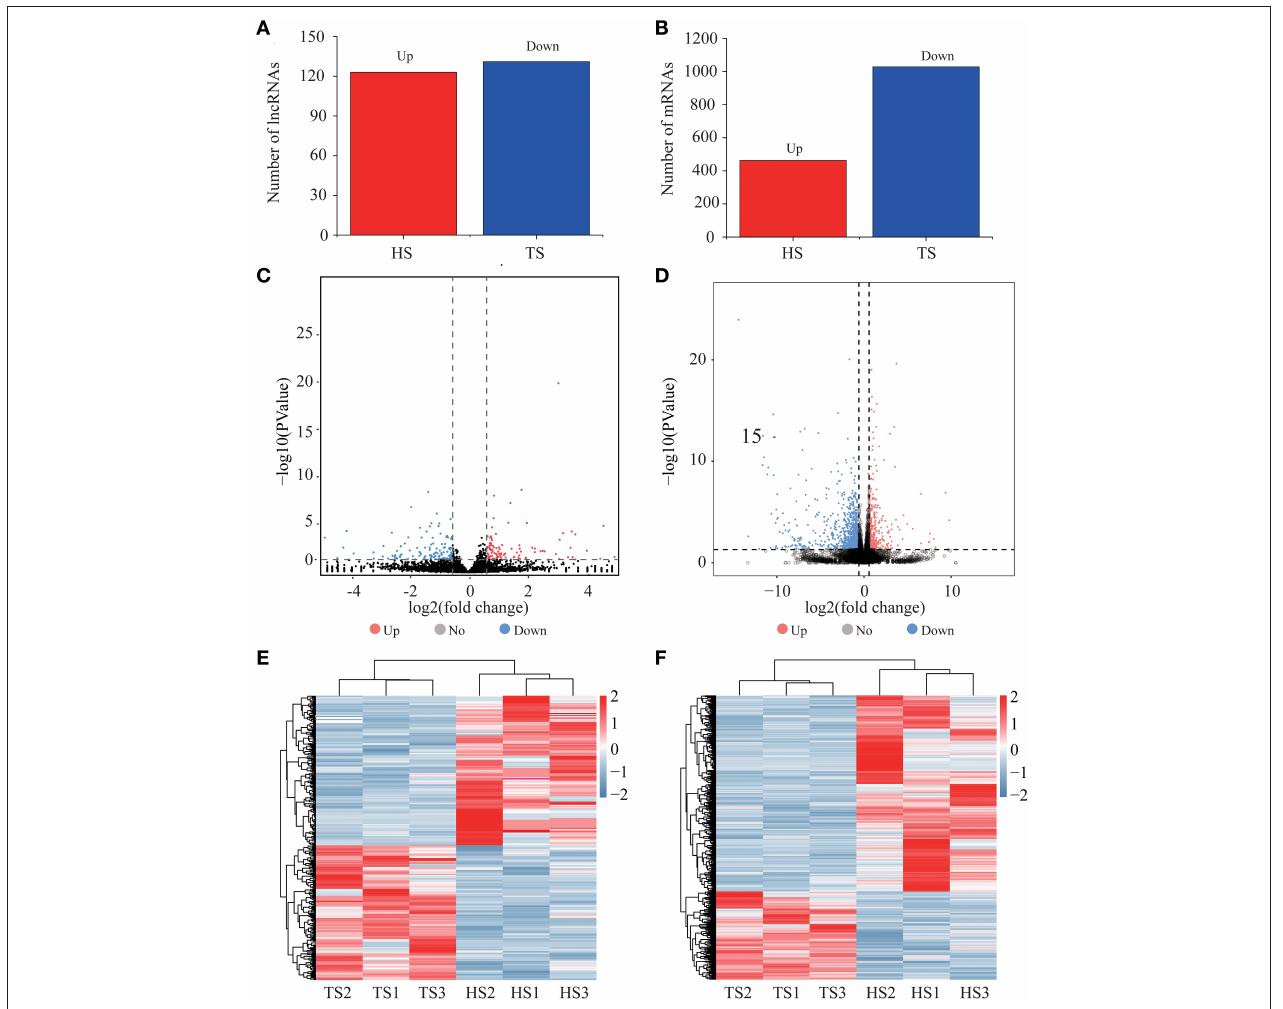
FIGURE 2 | Expression analysis of lncRNAs and mRNAs. (A) Numbers of upregulated and downregulated differentially expressed lncRNAs. (B) Numbers of upregulated and downregulated differentially expressed mRNAs. (C) Volcano plots displaying differentially expressed lncRNAs. (D) Volcano plots displaying differentially expressed mRNAs. (E) Heatmap of differentially expressed lncRNAs. (F) Heatmap of differentially expressed